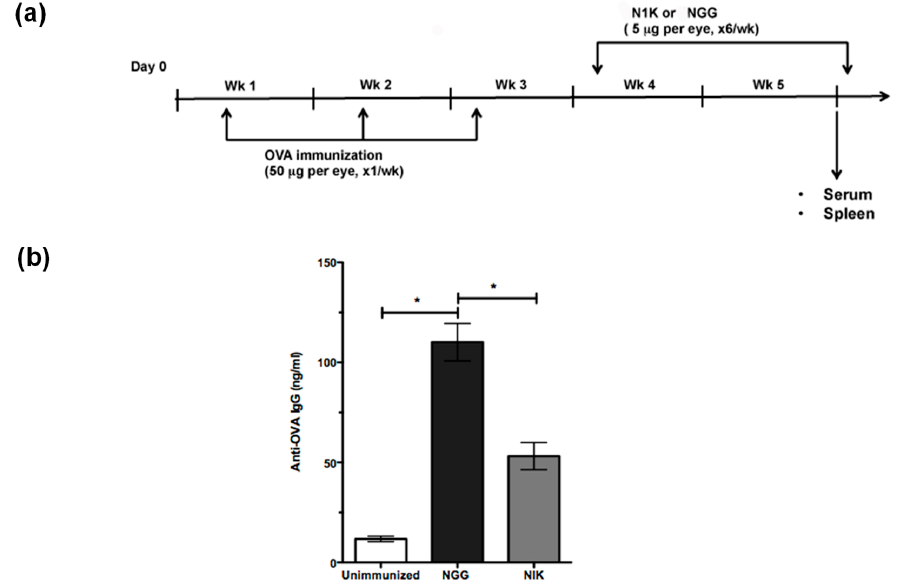
Figure 5. Topically administered TSP-derived peptides attenuate ovalbumin-specific antibody response in immunized TSP1 − / − mice. ( a ) Timeline of ovalbumin (OVA) immunization and subsequent treatment of TSP1 − / − mice with TSP1-derived peptide (N1K) or control peptide (NGG). ( b ) Serum anti-OVA IgG levels as determined by ELISA; Mean Ab level +/ − SEM. Data are representative of two independent experiments; * p < 0.05.